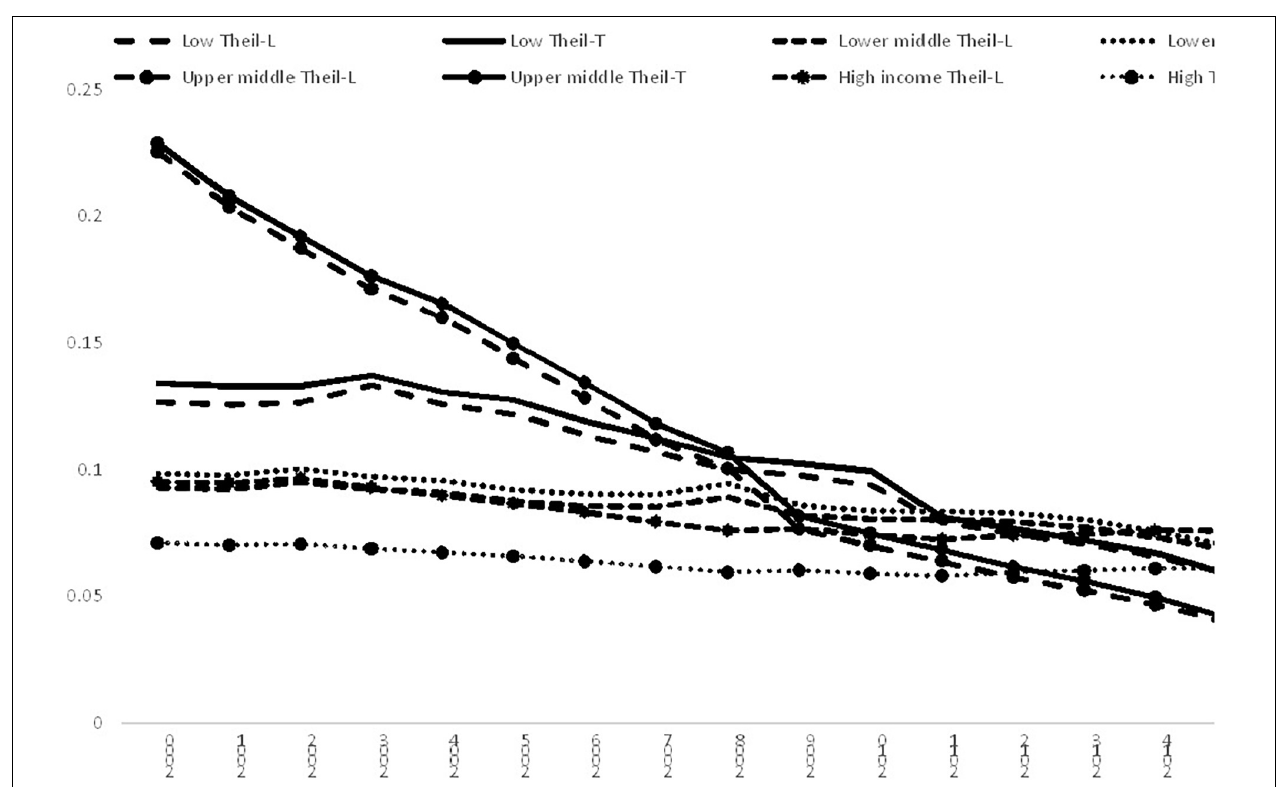
FIGURE 4 | Income inequality for different income subgroups, 2000–2017. Source: Authors’